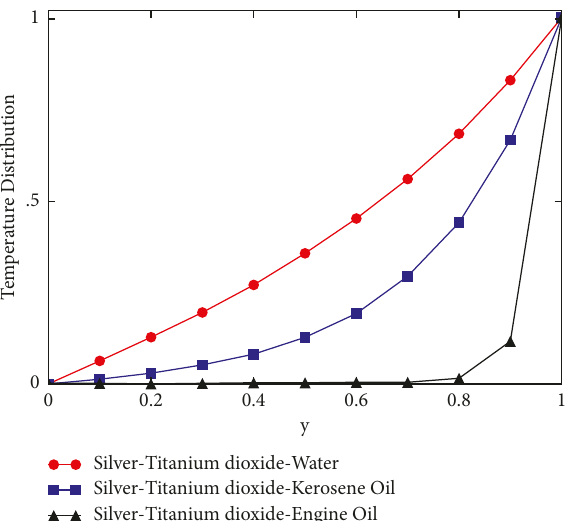
Figure 13: Comparison among unlike base fluids (engine oil, water and kerosene) for Temperature after α 0 . ϕ hnf (cid:30)